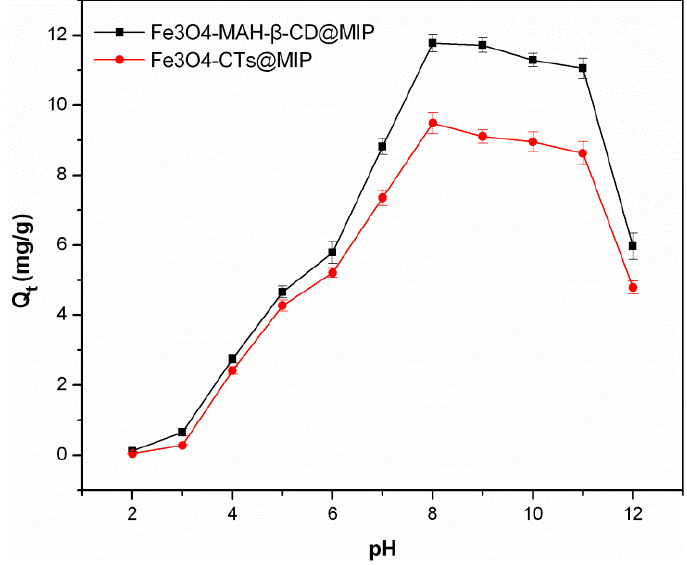
Figure 7. Effect of pH on the adsorption of 2-aminopyridine on the Fe 3 O 4 -MAH- β -CD@MIP and Fe 3 O 4 -CTs@MIP.